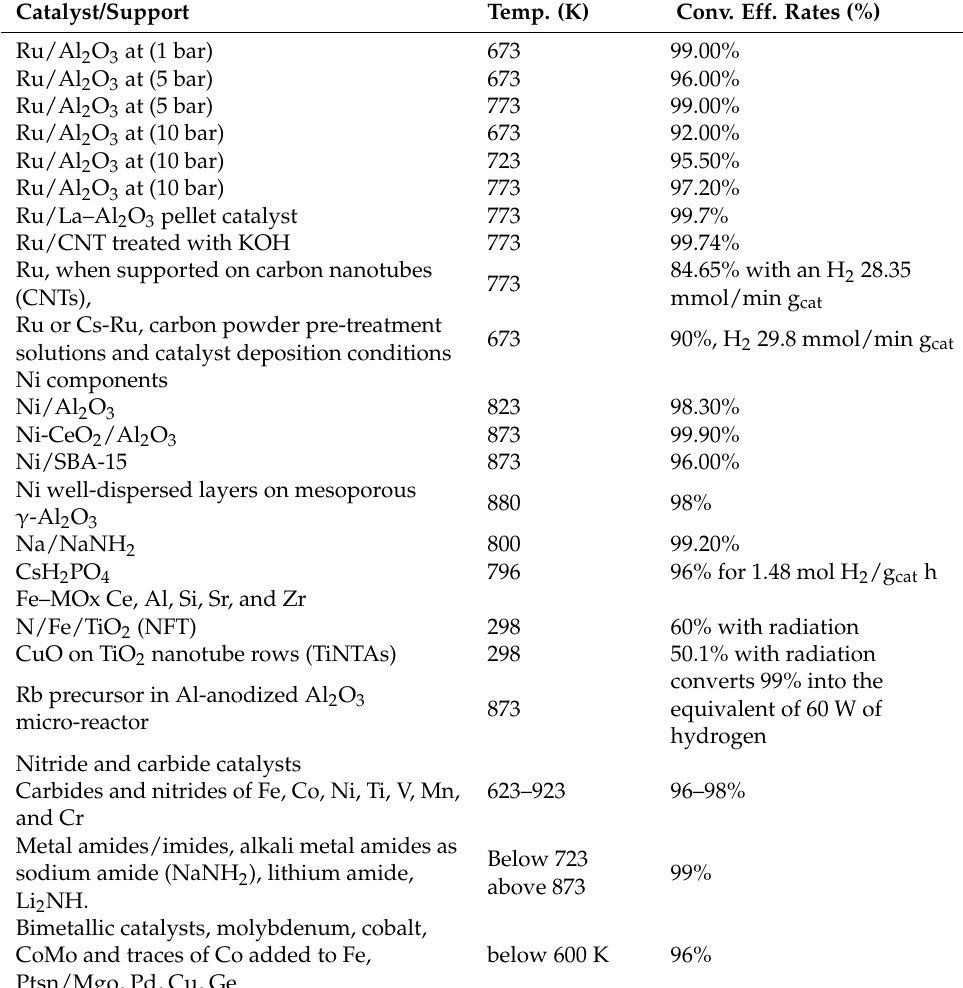
Table 12. Summary of ammonia decomposition catalysts based on reaction temperature, performance, conversion and efficiency rates. Reprinted with permission